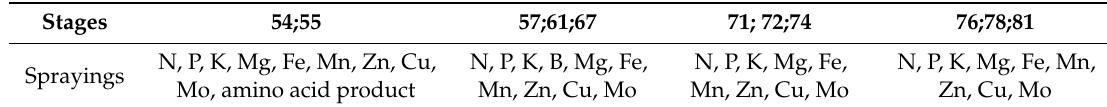
Table 3. Foliar nutrition program.